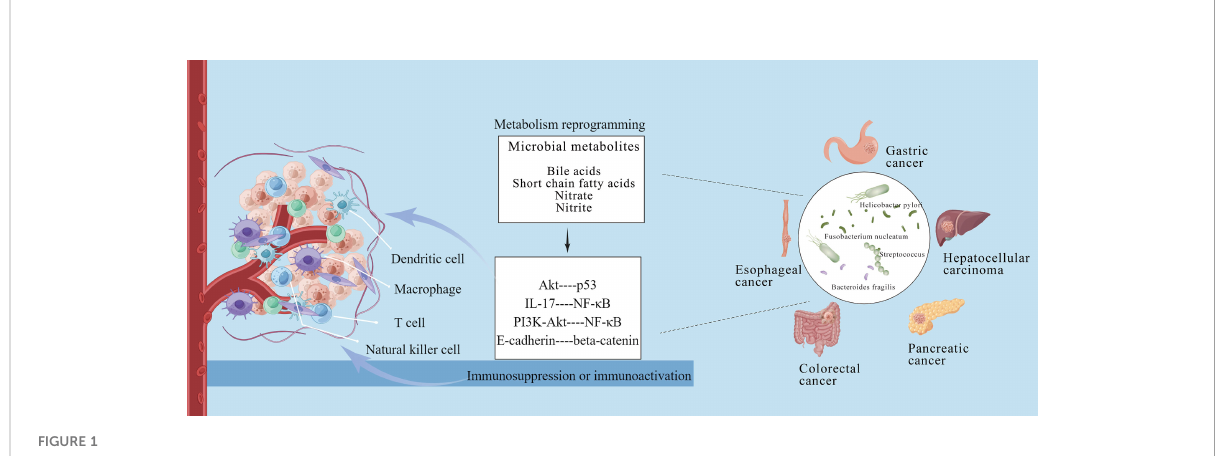
FIGURE 1 Crosstalk between intratumoral microbiome of gastrointestinal cancers and tumor microenvironment. The intratumoral microbiota can induce immunosuppression or immunoactivation via metabolism reprogramming, and form a heterogeneity tumor microenvironment to affect tumor occurrence and development. This fi gure is drawn by